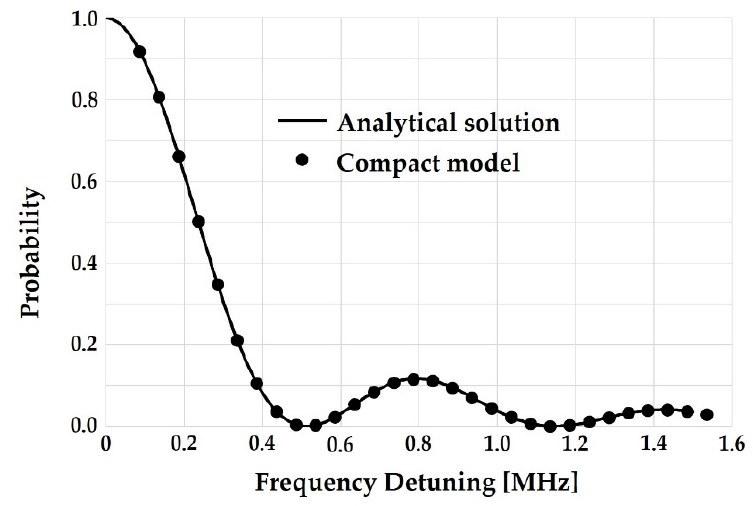
Figure 5. 35 kHz frequency compensated simulated chevron cross-sections vs. analytical chevron cross-section for P 0 for the second peak of the Rabi oscillation ( τ p = 5.067 μ s) in the case of different integration method.